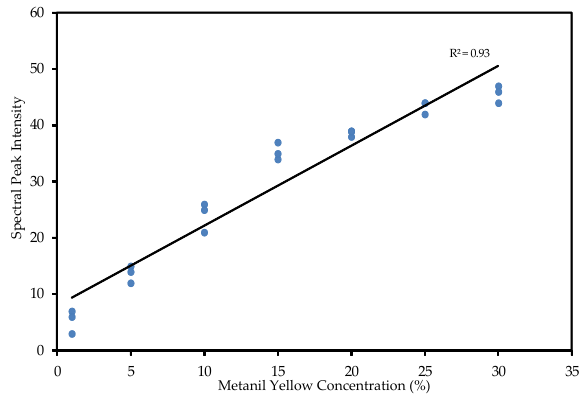
Figure 6. Linear relation between FT-Raman spectral peak intensity and corresponding sample concentration.